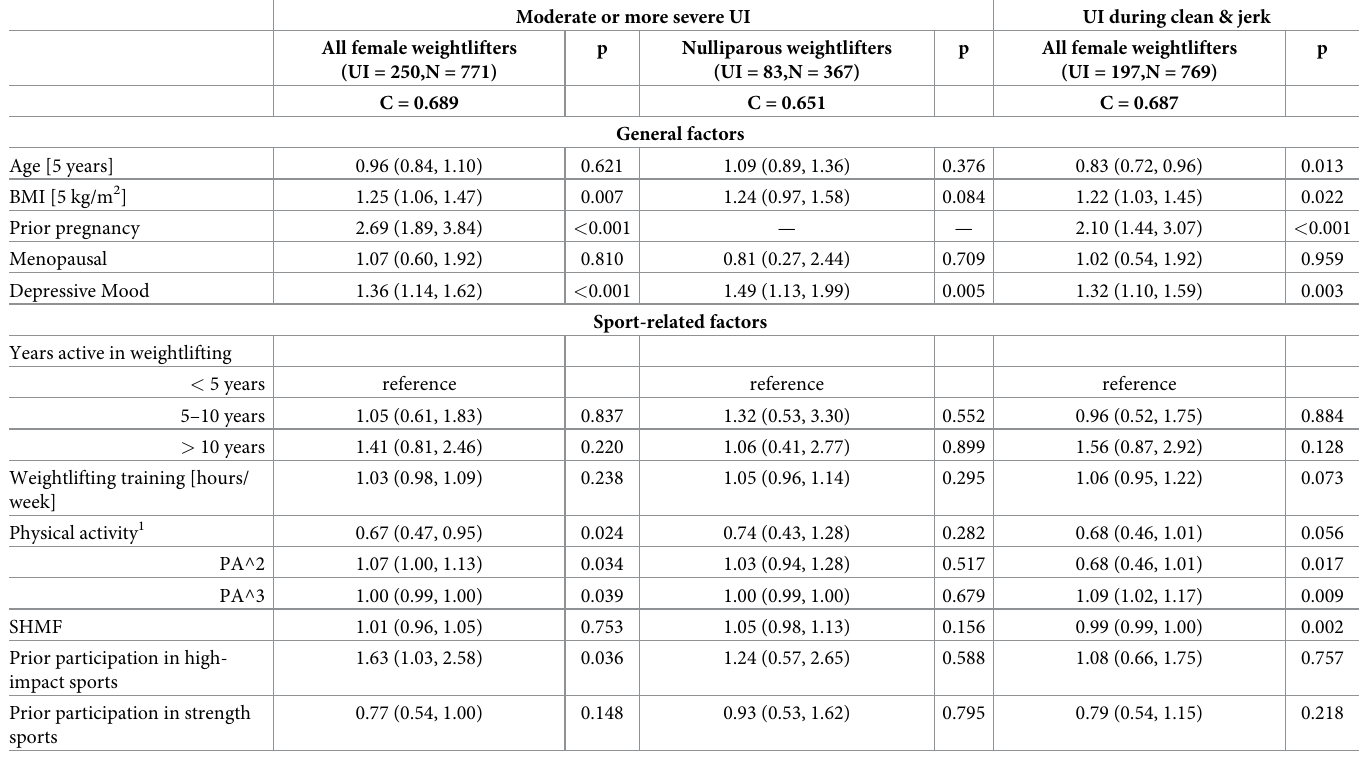
Table 2. Odds ratios (95% confidence intervals) for moderate or more severe UI in all female weightlifters and in the subgroup of nulliparous